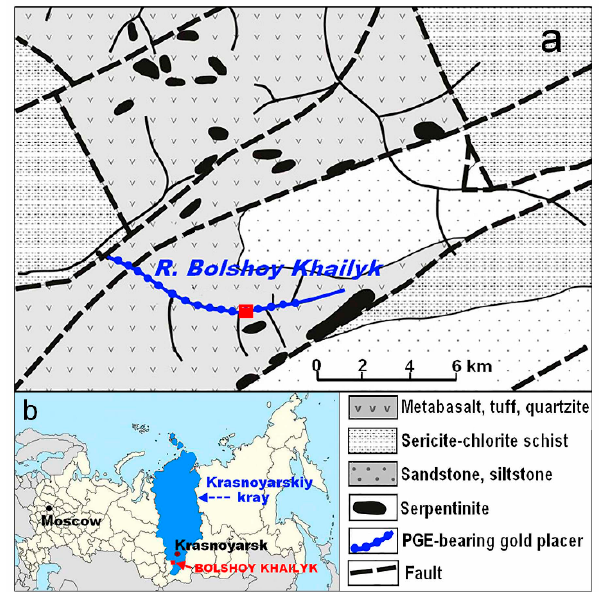
Figure 1. ( a ) Regional geology of the placer area at Bolshoy Khailyk (Figure 1a: simplified after [4]) and ( b ) a general map showing the location of the area in the Russian Federation (shown by red square symbol).